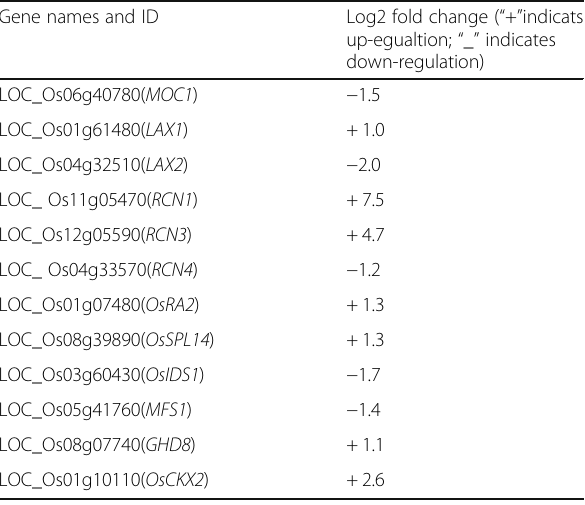
Table 1 Expression of some panicle related genes in the microarray data of the cs mutant Gene names and